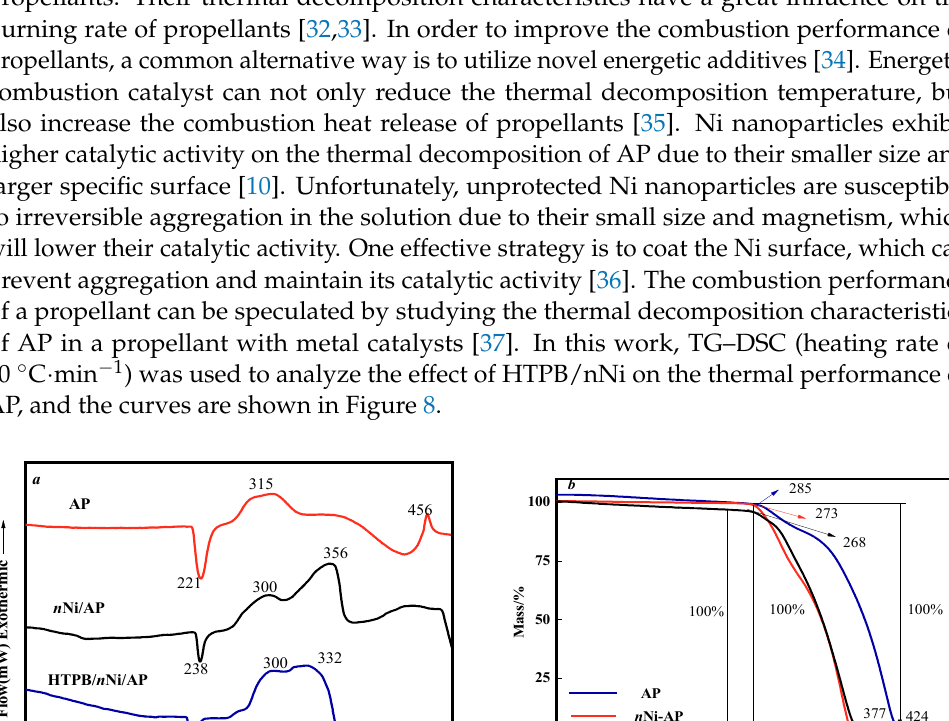
Figure 7. TG-DSC curves of nNi ( a ) and HTPB/nNi ( b ). The DSC curve of HTPB/nNi also has two exothermic peaks in the temperature range of 200–350 °C (Figure 7b), corresponding to a weight loss of about 8.1%, which is caused